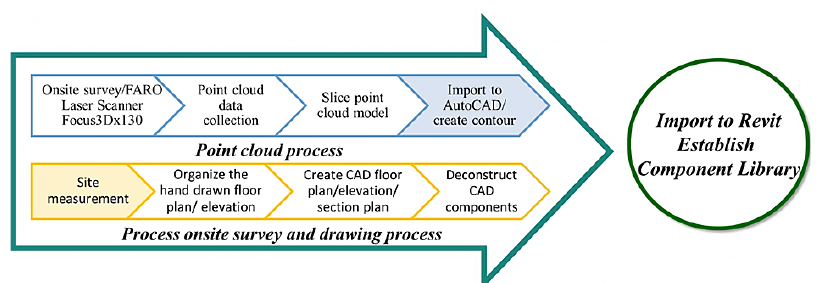
Figure 3. 3D modeling